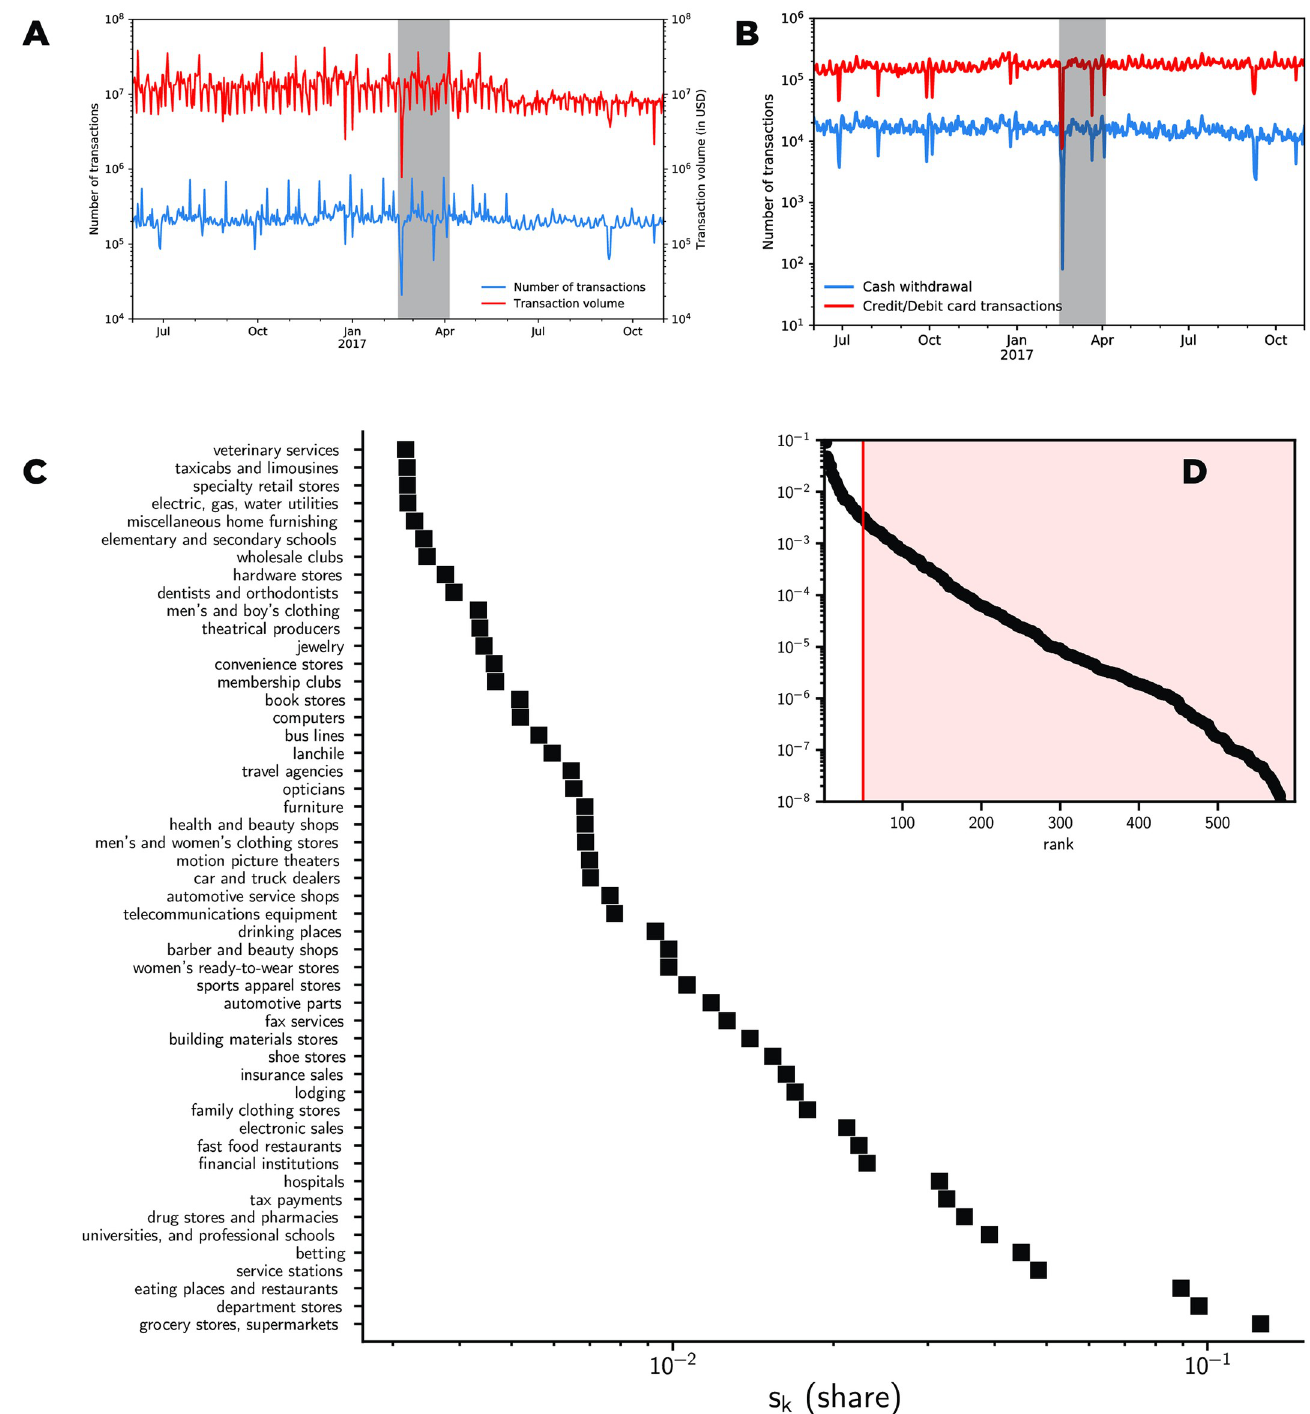
Fig 1. Bank transaction time series and distribution. a ) Transaction volume (red) and frequency (blue) in time. b ) Transaction frequency S transaction type is defined by the merchant category code (MCC) of a merchant (only the 50 most frequent MCC codes are displayed). c ) Full distribution of the MCC